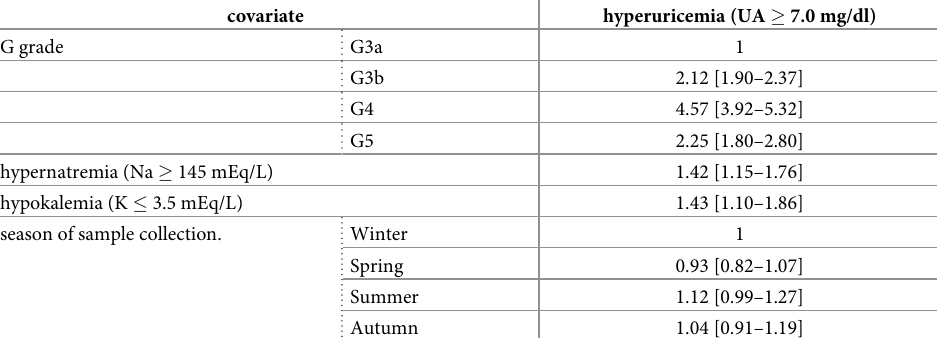
Table 4. Adjusted odds ratios and 95% confidence intervals for